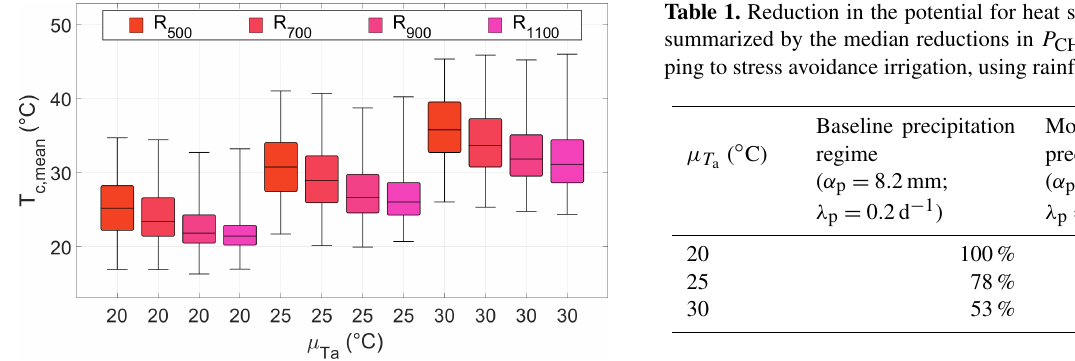
Figure 4. Distribution of mean canopy temperatures during anthe- sis, T c, mean , for four average annual precipitation totals (500, 700, 900, and 1110mm; colors) and three long-term average air temper- atures µ T (20, 25, and 30 ◦ C; x axis). Average precipitation depth a α p was kept at 15mm, while average precipitation frequency λ p changed within each group of four bars, left to right, from 0.091 to 0.137, 0.183, and 0.228d − 1 , leading to increasing average annual precipitation totals (subscripts in the legend). For each climatic sce- nario, 500 simulations of 21d each were run. The horizontal black lines are the median values. The boxes extend from the first to the third quartile; whiskers cover the whole range.